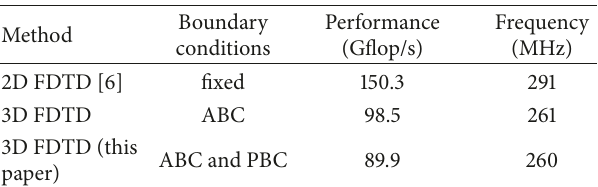
Table 5: Performance comparison against FPGA accelerators that use simple boundary